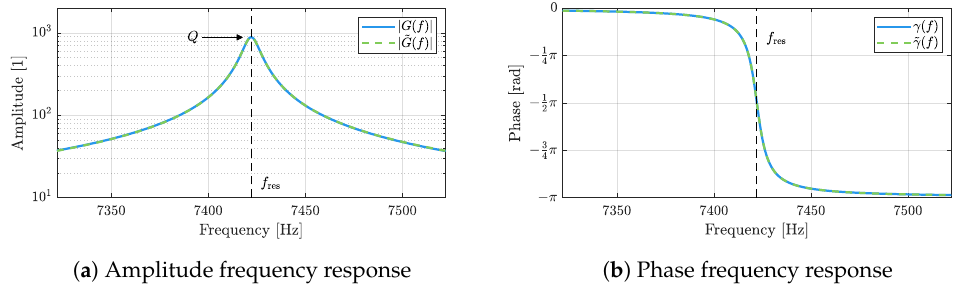
Figure 2. Comparison of amplitude ( a ) and phase frequency responses ( b ) between the original ex- pression for the frequency response of a damped harmonic oscillator (Equation (2)) and the